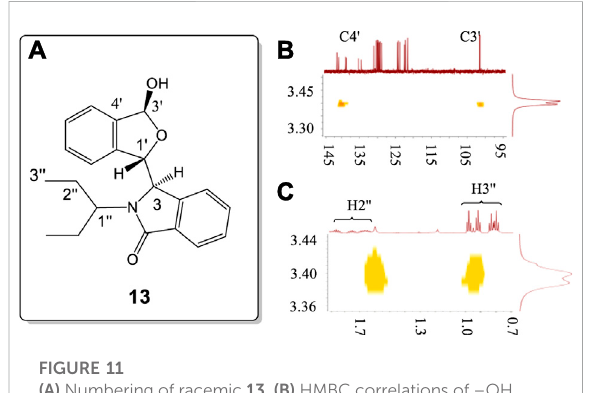
FIGURE 11 (A) Numbering of racemic 13 . (B) HMBC correlations of – OH proton with the C3 ’ (102.3 ppm) and C4 ’ (140.4 ppm) signals of 13 . (C) NOESY correlations of the − OH proton with the H2 ″ , and H3 ″ protons of only a single ethyl of the 3-pentyl group in 13 . All units in ppm.